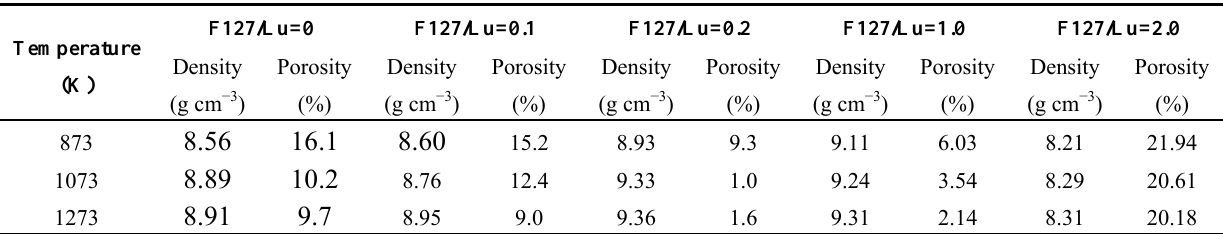
Table 2. Density and porosity of Lu annealing temperature and F127/Lu molar